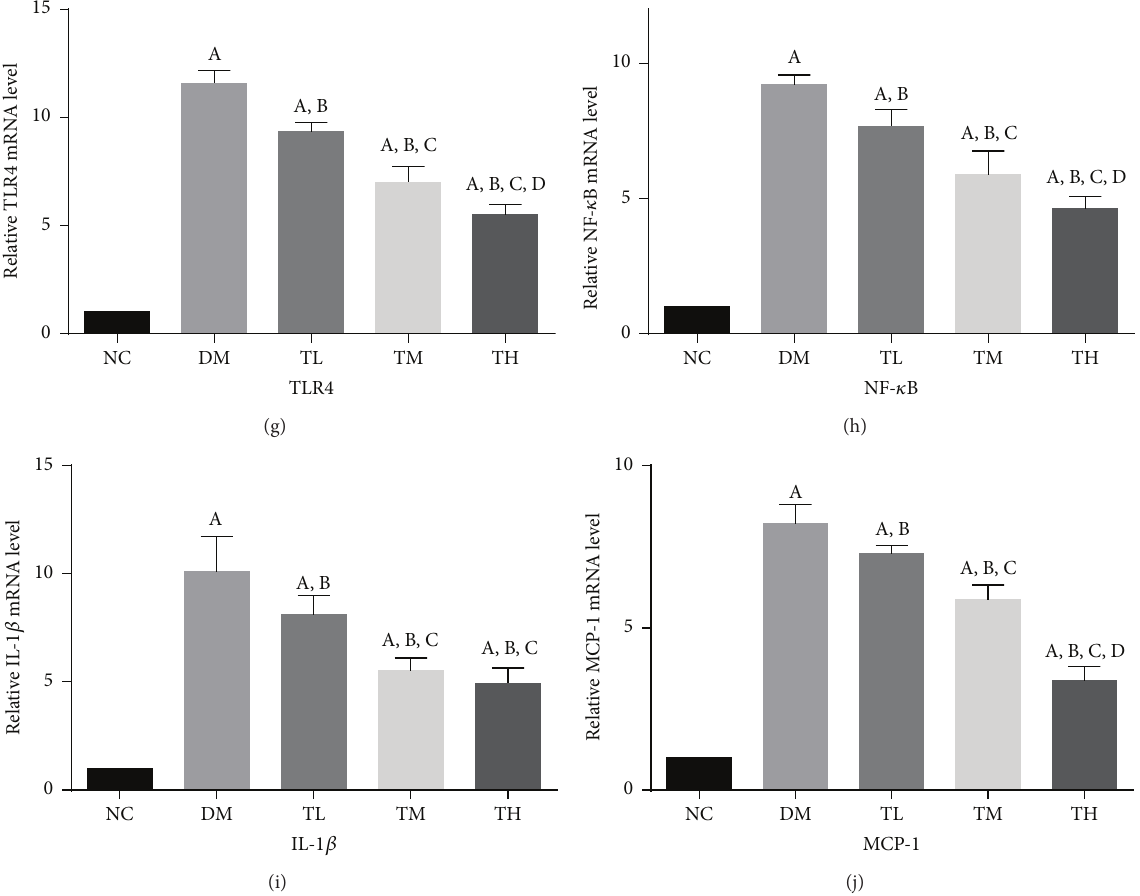
Figure 3: TGT attenuated diabetes-induced renal inflammation. (a) Immunostaining of TLR4, NF- 𝜅 B, IL-1 𝛽 , and MCP-1 was shown for different groups. (b) Representative western blotting analysis of TLR4, NF- 𝜅 B, IL-1 𝛽 , and MCP-1 was shown for different groups. (c–f) Densitometric results of TLR4, NF- 𝜅 B, IL-1 𝛽 , and MCP-1, as determined by western blot. (g–j) The mRNA expressions of TLR4, NF- 𝜅 B, IL-1 𝛽 , and MCP-1 were shown for different groups. NC: normal control; DM: diabetic rats without drug treatment; TL: low-dose TGT (1mg/kg/day); TM: medium-dose TGT (3mg/kg/day); TH: high-dose TGT (6mg/kg/day). A 𝑝 < 0.05 versus NC group, B 𝑝 < 0.05 versus DM group, C 𝑝 < 0.05 versus TL group, and D 𝑝 < 0.05 versus TM